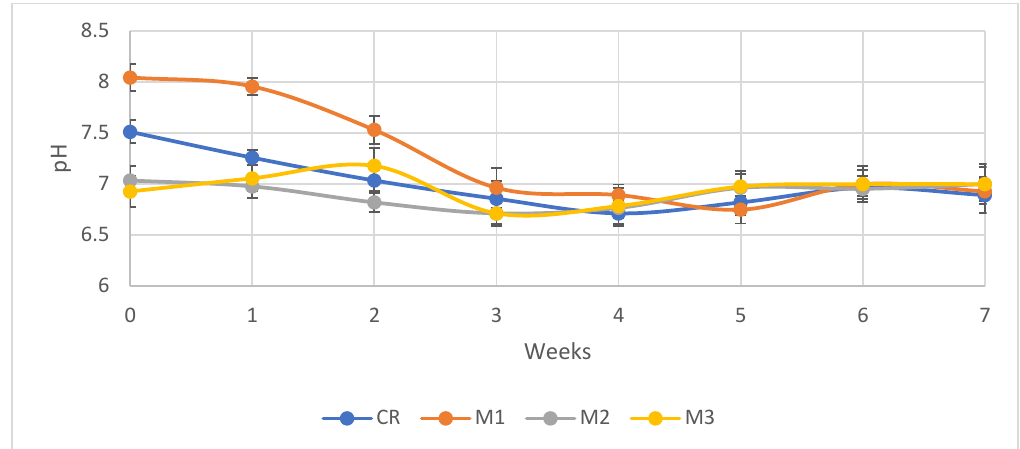
Figure 7. pH behavior in mixtures (CR, M1, M2 and M3) during vermicomposting process.